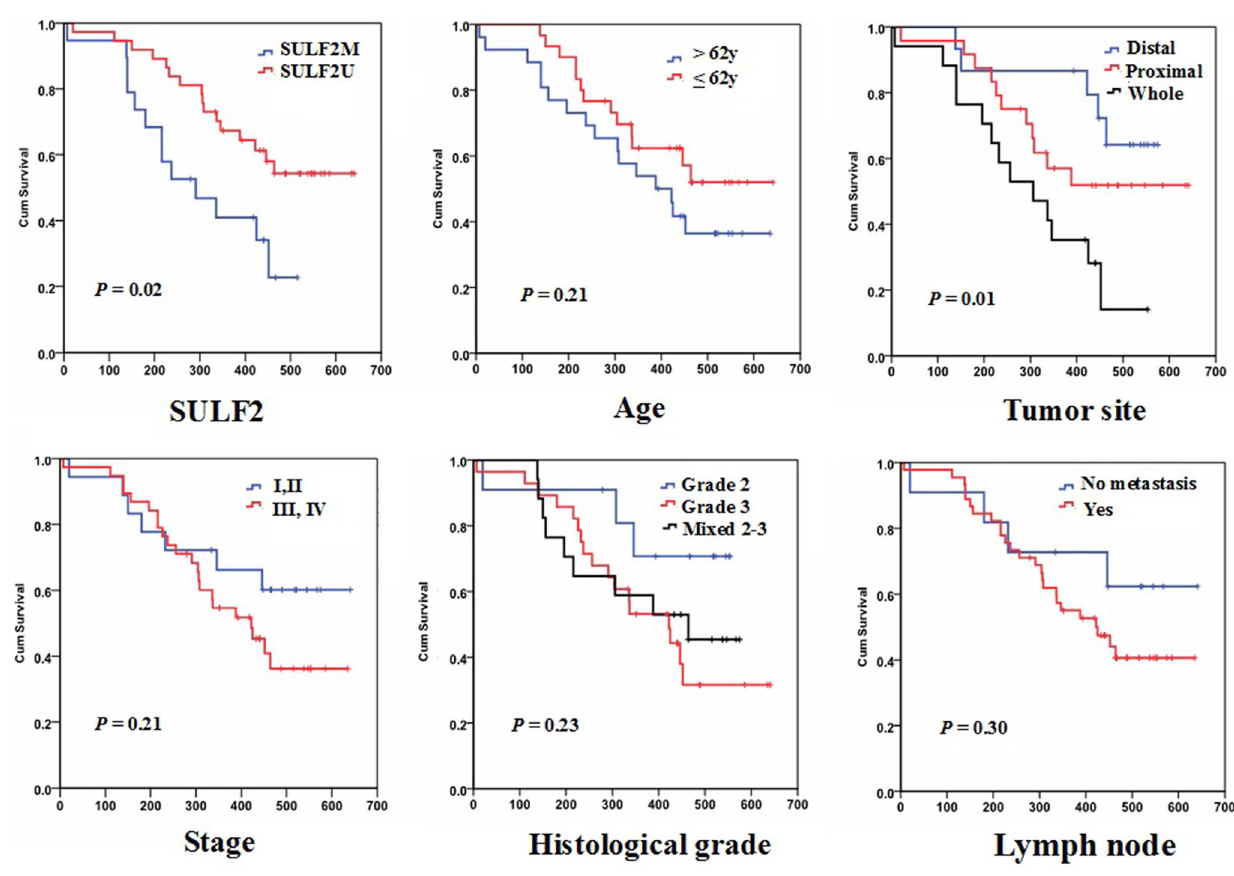
Figure 3. Kaplan–Meier estimates of overall survival by SULF2 methylation status and clinical characteristics.